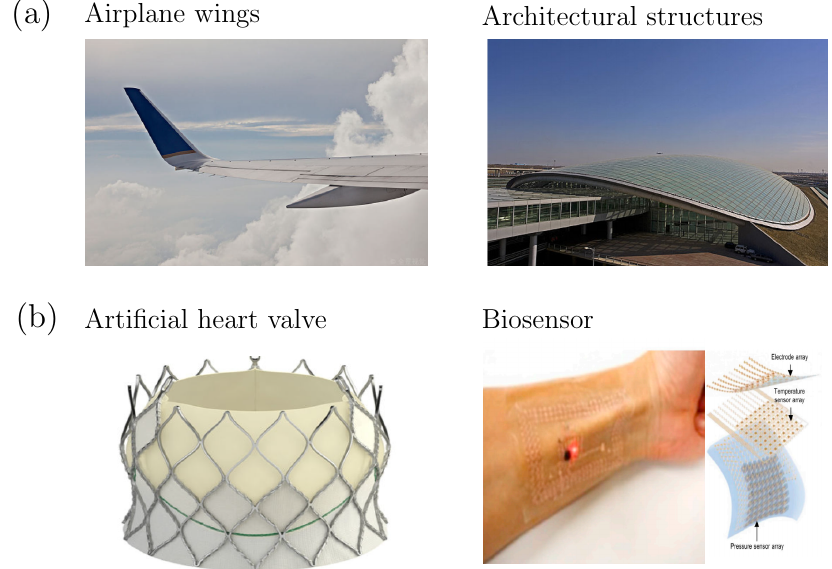
Figure 1. Shell structure. ( a ) Aircraft wing [18] and architectural structures [19]; ( b ) Artificial heart valve (reprinted with permission from Ref. [20]. Copyright 2017, Elsevier) and biosensor (reprinted with permission from Ref. [21]. Copyright 2020, Springer